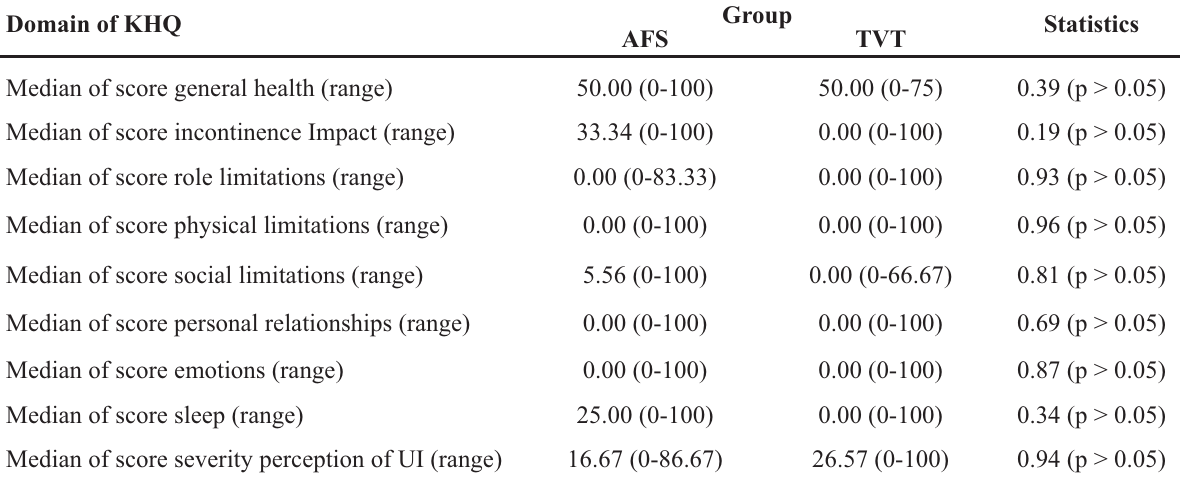
Table 4 – (cid:51)(cid:82)(cid:86)(cid:87)(cid:82)(cid:83)(cid:72)(cid:85)(cid:68)(cid:87)(cid:76)(cid:89)(cid:72)(cid:3)(cid:72)(cid:89)(cid:68)(cid:79)(cid:88)(cid:68)(cid:87)(cid:76)(cid:82)(cid:81)(cid:3)(cid:82)(cid:73)(cid:3)(cid:70)(cid:82)(cid:81)(cid:71)(cid:76)(cid:87)(cid:76)(cid:82)(cid:81)(cid:16)(cid:86)(cid:83)(cid:72)(cid:70)(cid:76)(cid:191)(cid:70)(cid:3)(cid:84)(cid:88)(cid:68)(cid:79)(cid:76)(cid:87)(cid:92)(cid:3)(cid:82)(cid:73)(cid:3)(cid:79)(cid:76)(cid:73)(cid:72)(cid:3)(cid:46)(cid:76)(cid:81)(cid:74)(cid:182)(cid:86)(cid:3)(cid:43)(cid:72)(cid:68)(cid:79)(cid:87)(cid:75)(cid:3)(cid:52)(cid:88)(cid:72)(cid:86)(cid:87)(cid:76)(cid:82)(cid:81)(cid:81)(cid:68)(cid:76)(cid:85)(cid:72)(cid:3)(cid:11)(cid:46)(cid:43)(cid:52)(cid:12)(cid:3)(cid:82)(cid:73)(cid:3)(cid:87)(cid:75)(cid:72)(cid:3)(cid:83)(cid:68)(cid:87)(cid:76)(cid:72)(cid:81)(cid:87)(cid:86)(cid:3) submitted to autologous fascial sling (AFS) and tension-free vaginal tape (TVT) at 36-month evaluation. Domain of